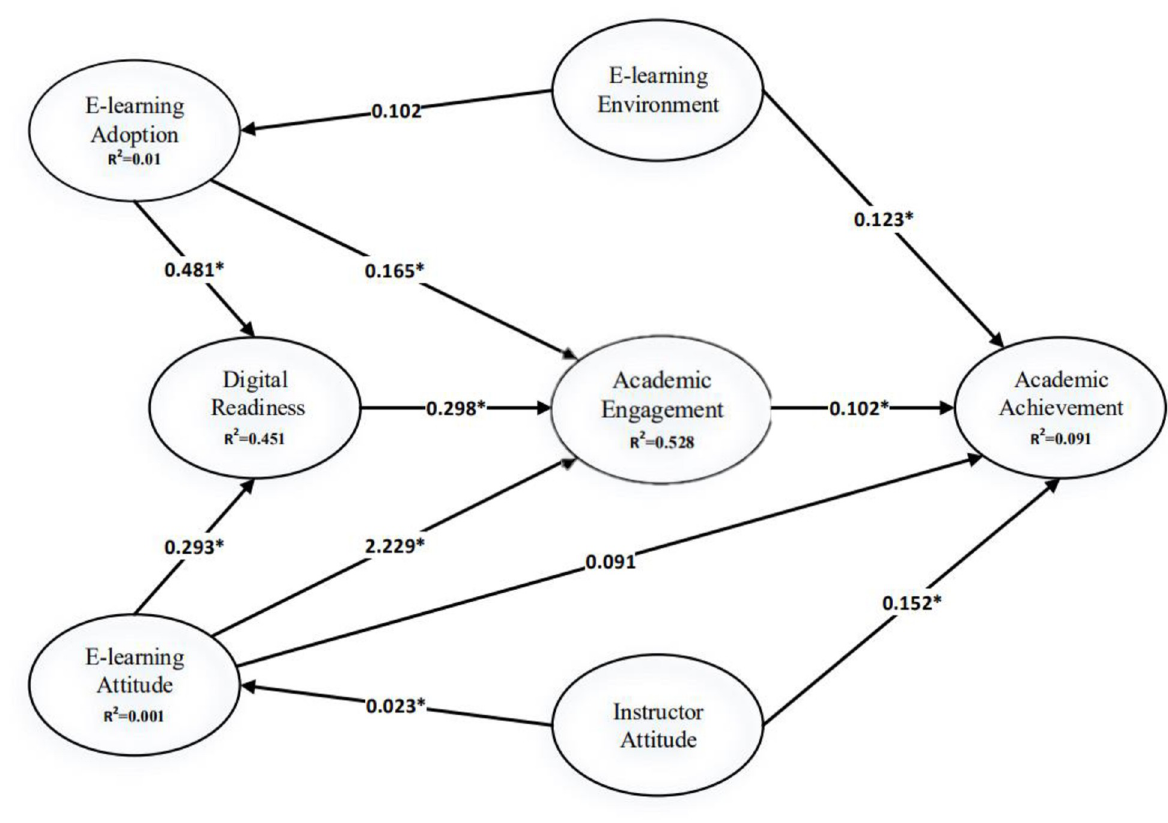
Fig 2. Standardized path